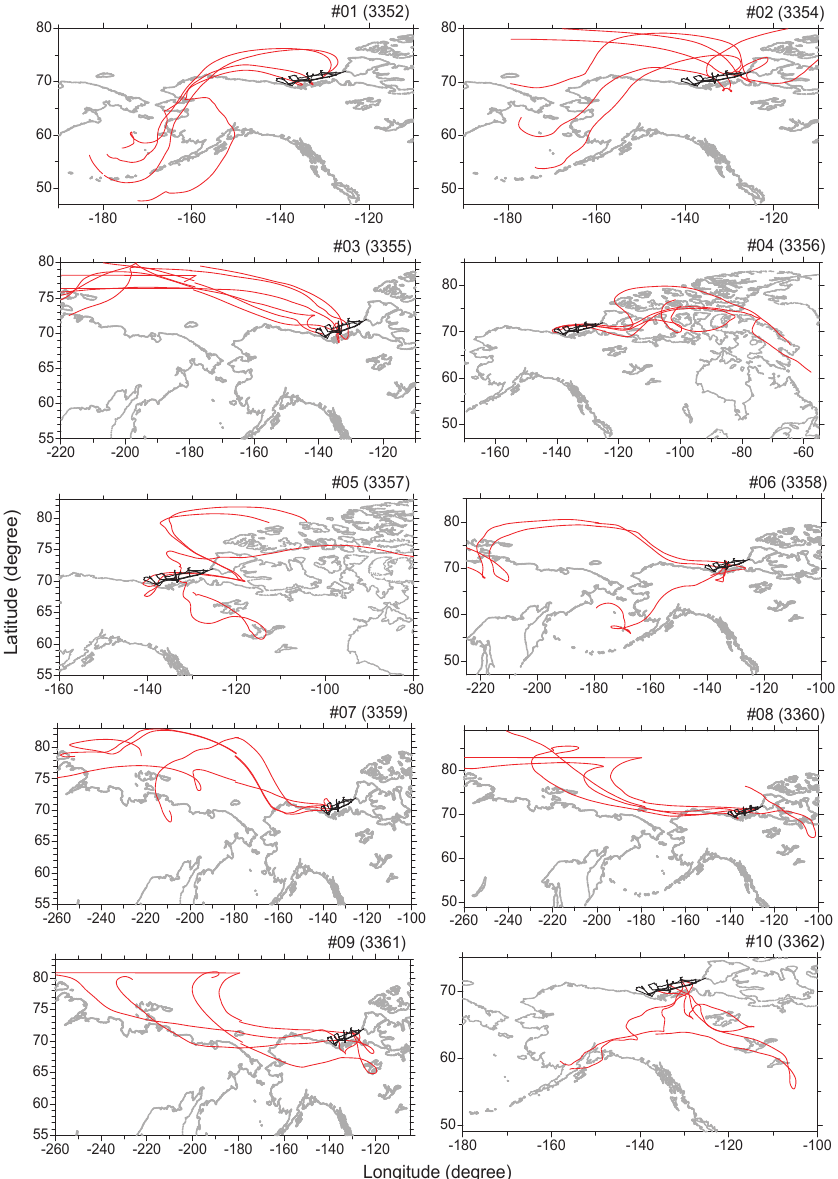
Fig. 5. Backward air mass trajectory analyses corresponding to the aerosol sample #1 to #10. The trajectories were calculated for seven days using the NOAA Hybrid Single-Particle Lagrangian Integrated Trajectory (Draxler and Rolph, 2003; Rolph, 2003).